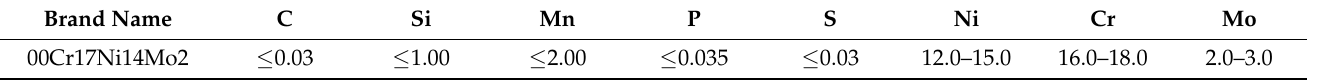
Figure 2. Morphology of 316L stainless steel powder. Table 1. Chemical composition of 316L stainless steel powder (%).